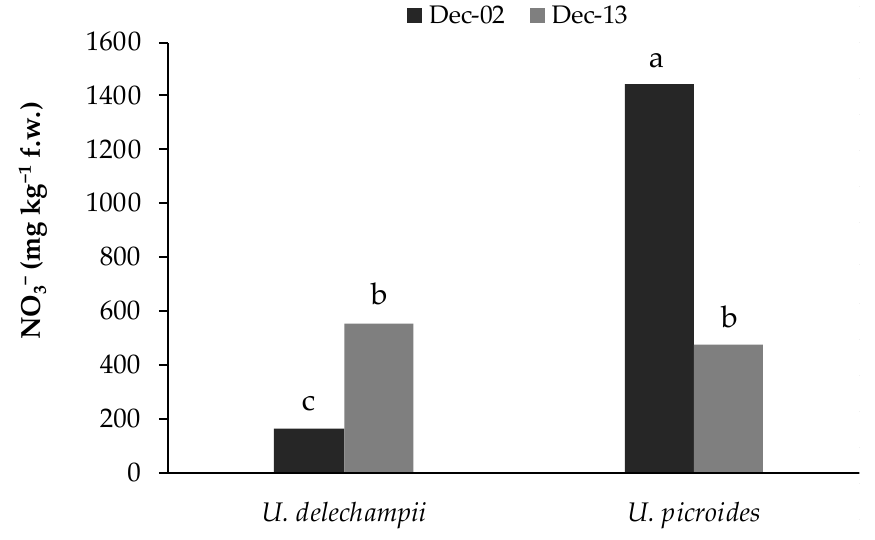
Figure 5. Nitrate content in wild U. delechampii and wild U. picroides gathered at two dates: 2 and 13 December. The same letters indicate that mean values are not significantly different ( p = 0.05).